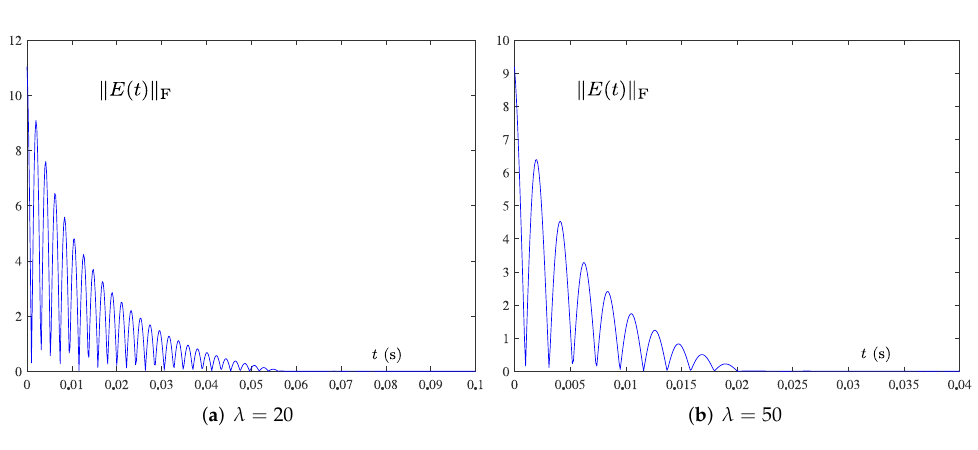
Figure 7. Simulation results under the constant periodic multiple-harmonic noise, OAZNN model (38) for TVMIP of (40) with λ = 20,50, respectively.